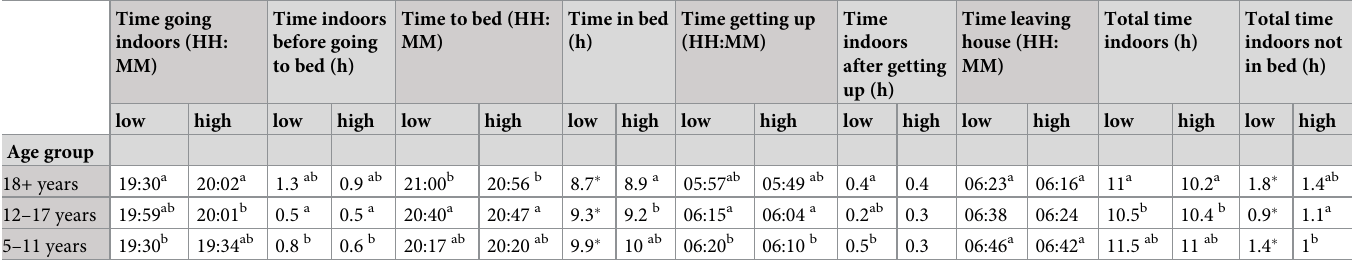
Low: Low transmission season. High: High transmissions